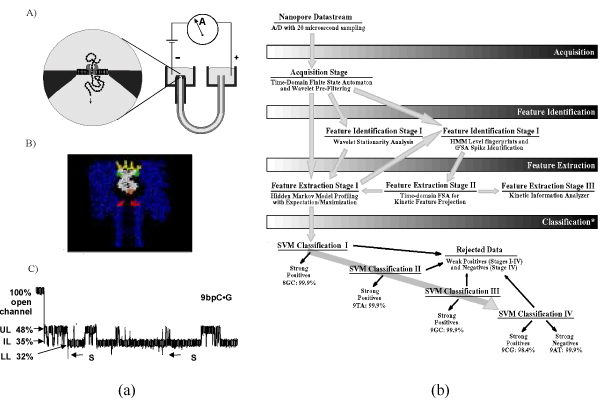
a. (A) shows a nanopore device based on the α-hemolysin channel. It has been used for analysis of single DNA molecules, such as ssDNA, shown, and dsDNA, a nine base-pair DNA hairpin is shown in (B) superimposed on the channel geometry. The channel current blockade trace for the nine base-pair DNA hairpin blockade from (B) is shown in (C). b shows the signal processing architecture that was used to classify DNA hairpins with this approach: Signal acquisition was performed using a time-domain, thresholding, Finite State Automaton, followed by adaptive pre-filtering using a wavelet-domain Finite State Automaton. Hidden Markov Model processing with Expectation-Maximization was used for feature extraction on acquired channel blockades. Classification was then done by Support Vector Machine on five DNA molecules: four DNA hairpin molecules with nine base-pair stem lengths that only differed in their blunt-ended DNA termini, and an eight base-pair DNA hairpin. The accuracy shown is obtained upon completing the 15th single molecule sampling/classification (in approx. 6 seconds), where SVM-based rejection on noisy signals was employed.